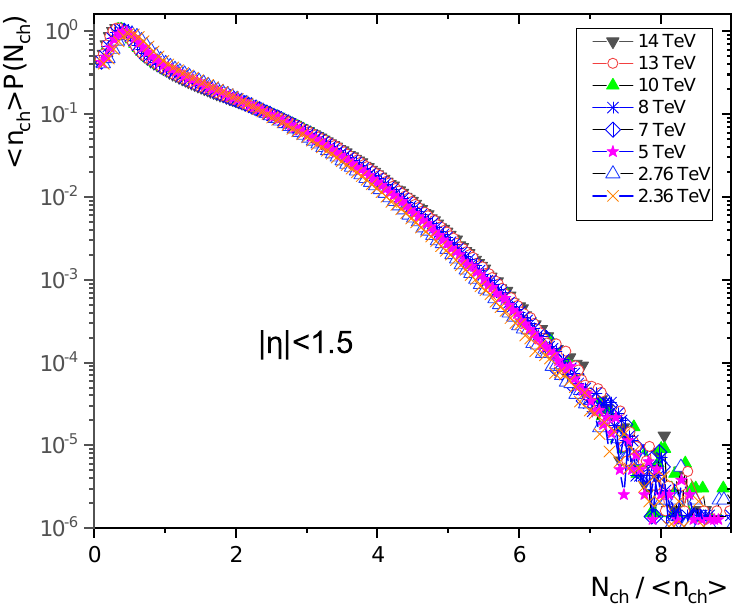
Figure 9. KNO form of charged particle multiplicity distribution at different energies in pseudorapid- ity | η | < 1.5.